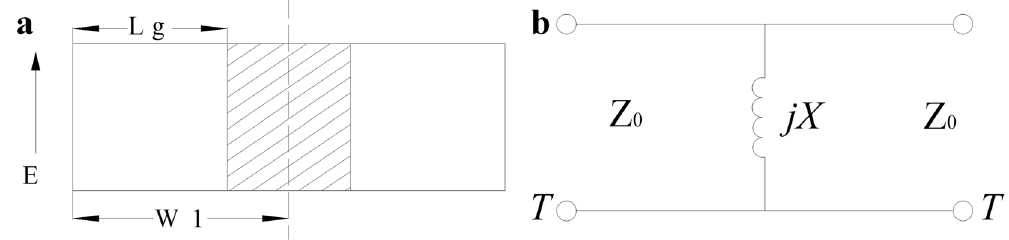
Figure 5. ( a ) Cross section view of SIW inductive window ( b ) Equivalent circuit.